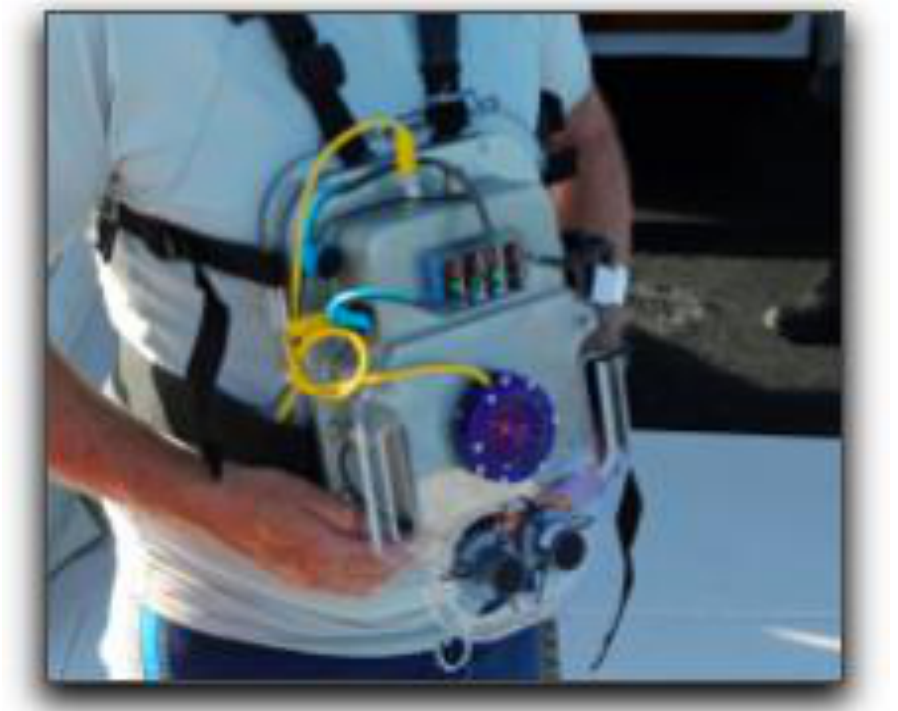
Figure 7. CHAT – Underwater wearable computer with real-time sound recognition used in the Bahamas with free-ranging Atlantic spotted dolphins. Picture used with permission – Wild Dolphin